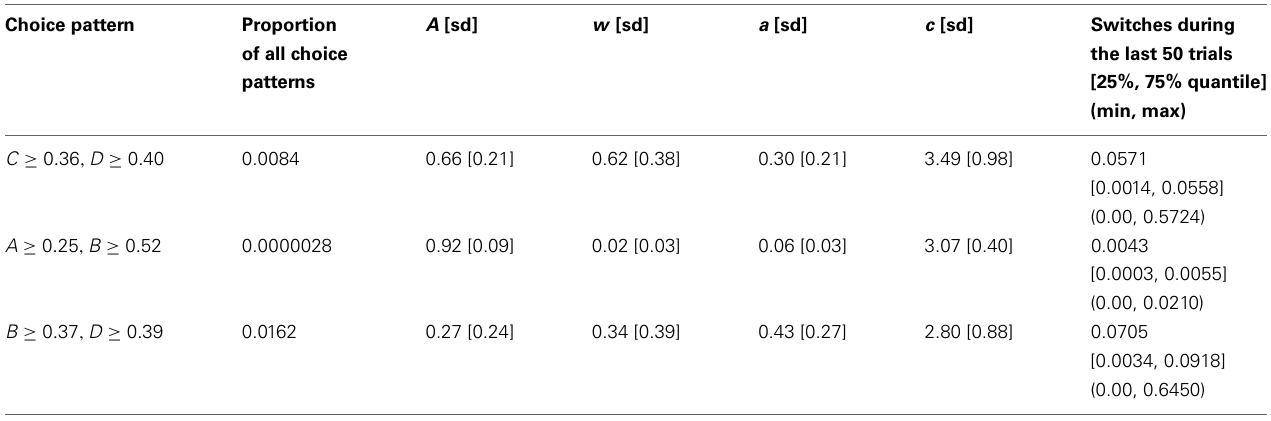
Table 4 | Proportion of choice patterns generated by the PVL-Delta model that satisfy the restricted definition of choice patterns. Choice pattern